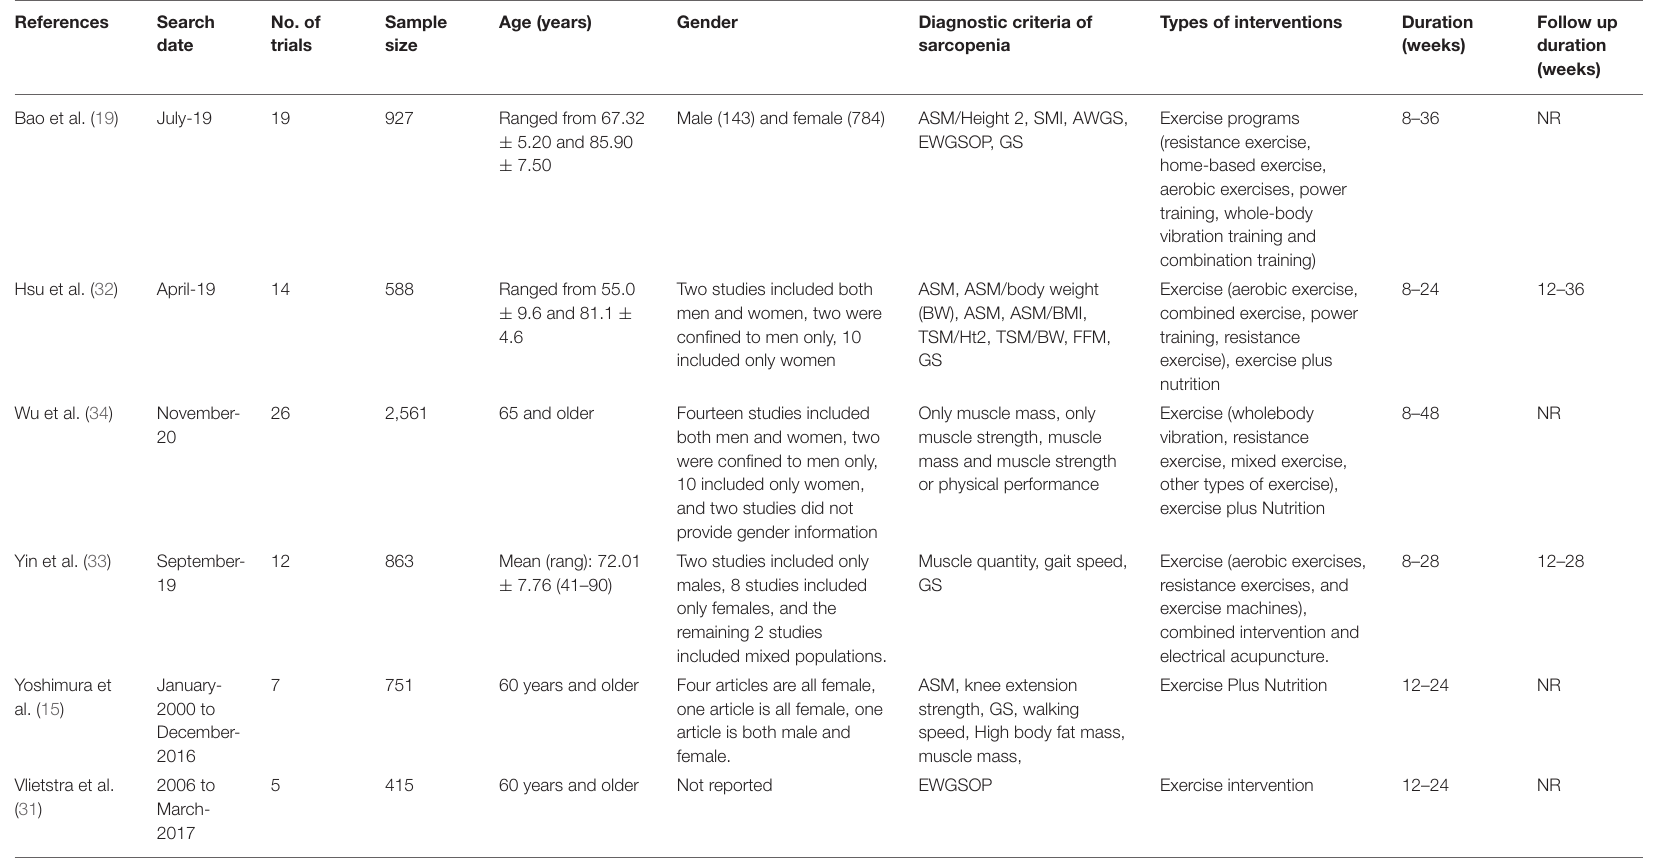
TABLE 1 | Characteristics of the included